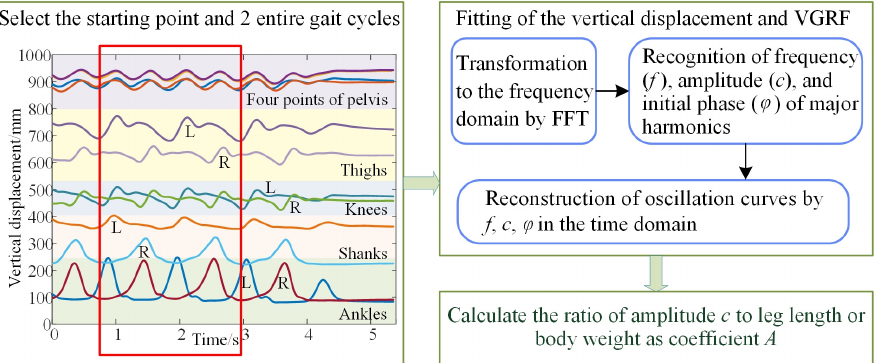
Figure 4. The generalizing process of the lower limb displacement description.